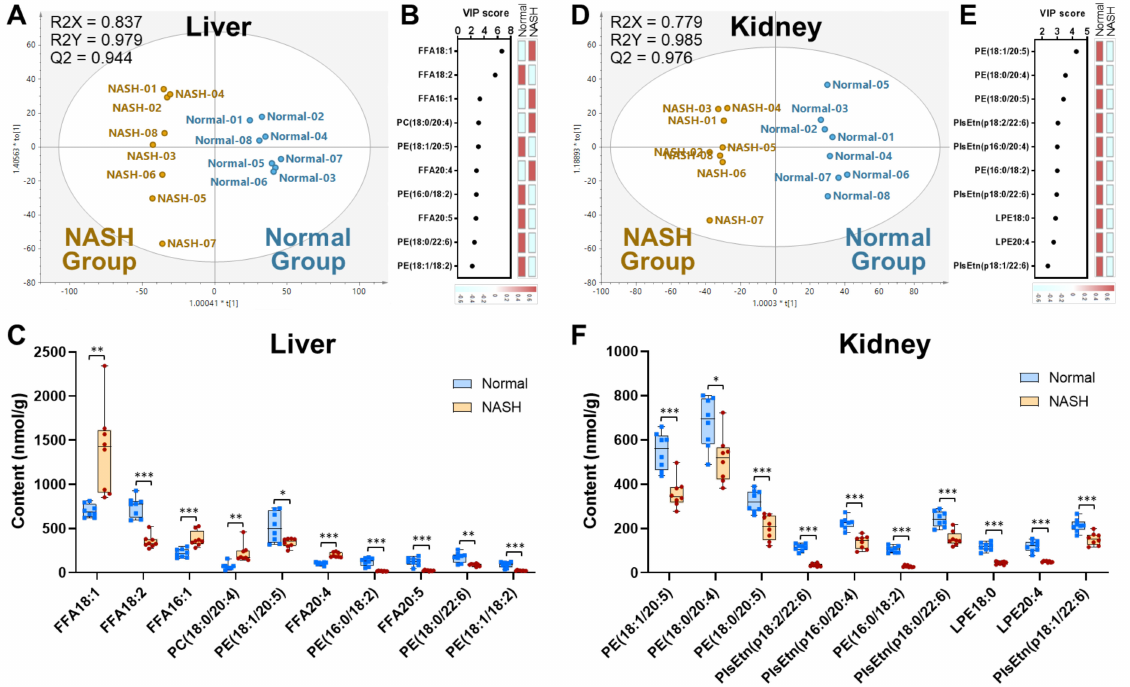
Figure 3. OPLS-DA of intact lipidomic characteristics in liver and kidney, including scatter plots ( A , D ), VIP ranking ( B , E ), and the amount comparison of the selected lipids ( C , F ) together with the VIP scores of the most significant variables. * p < 0.05, ** p < 0.01, *** p < 0.001, calculated by two-tailed t